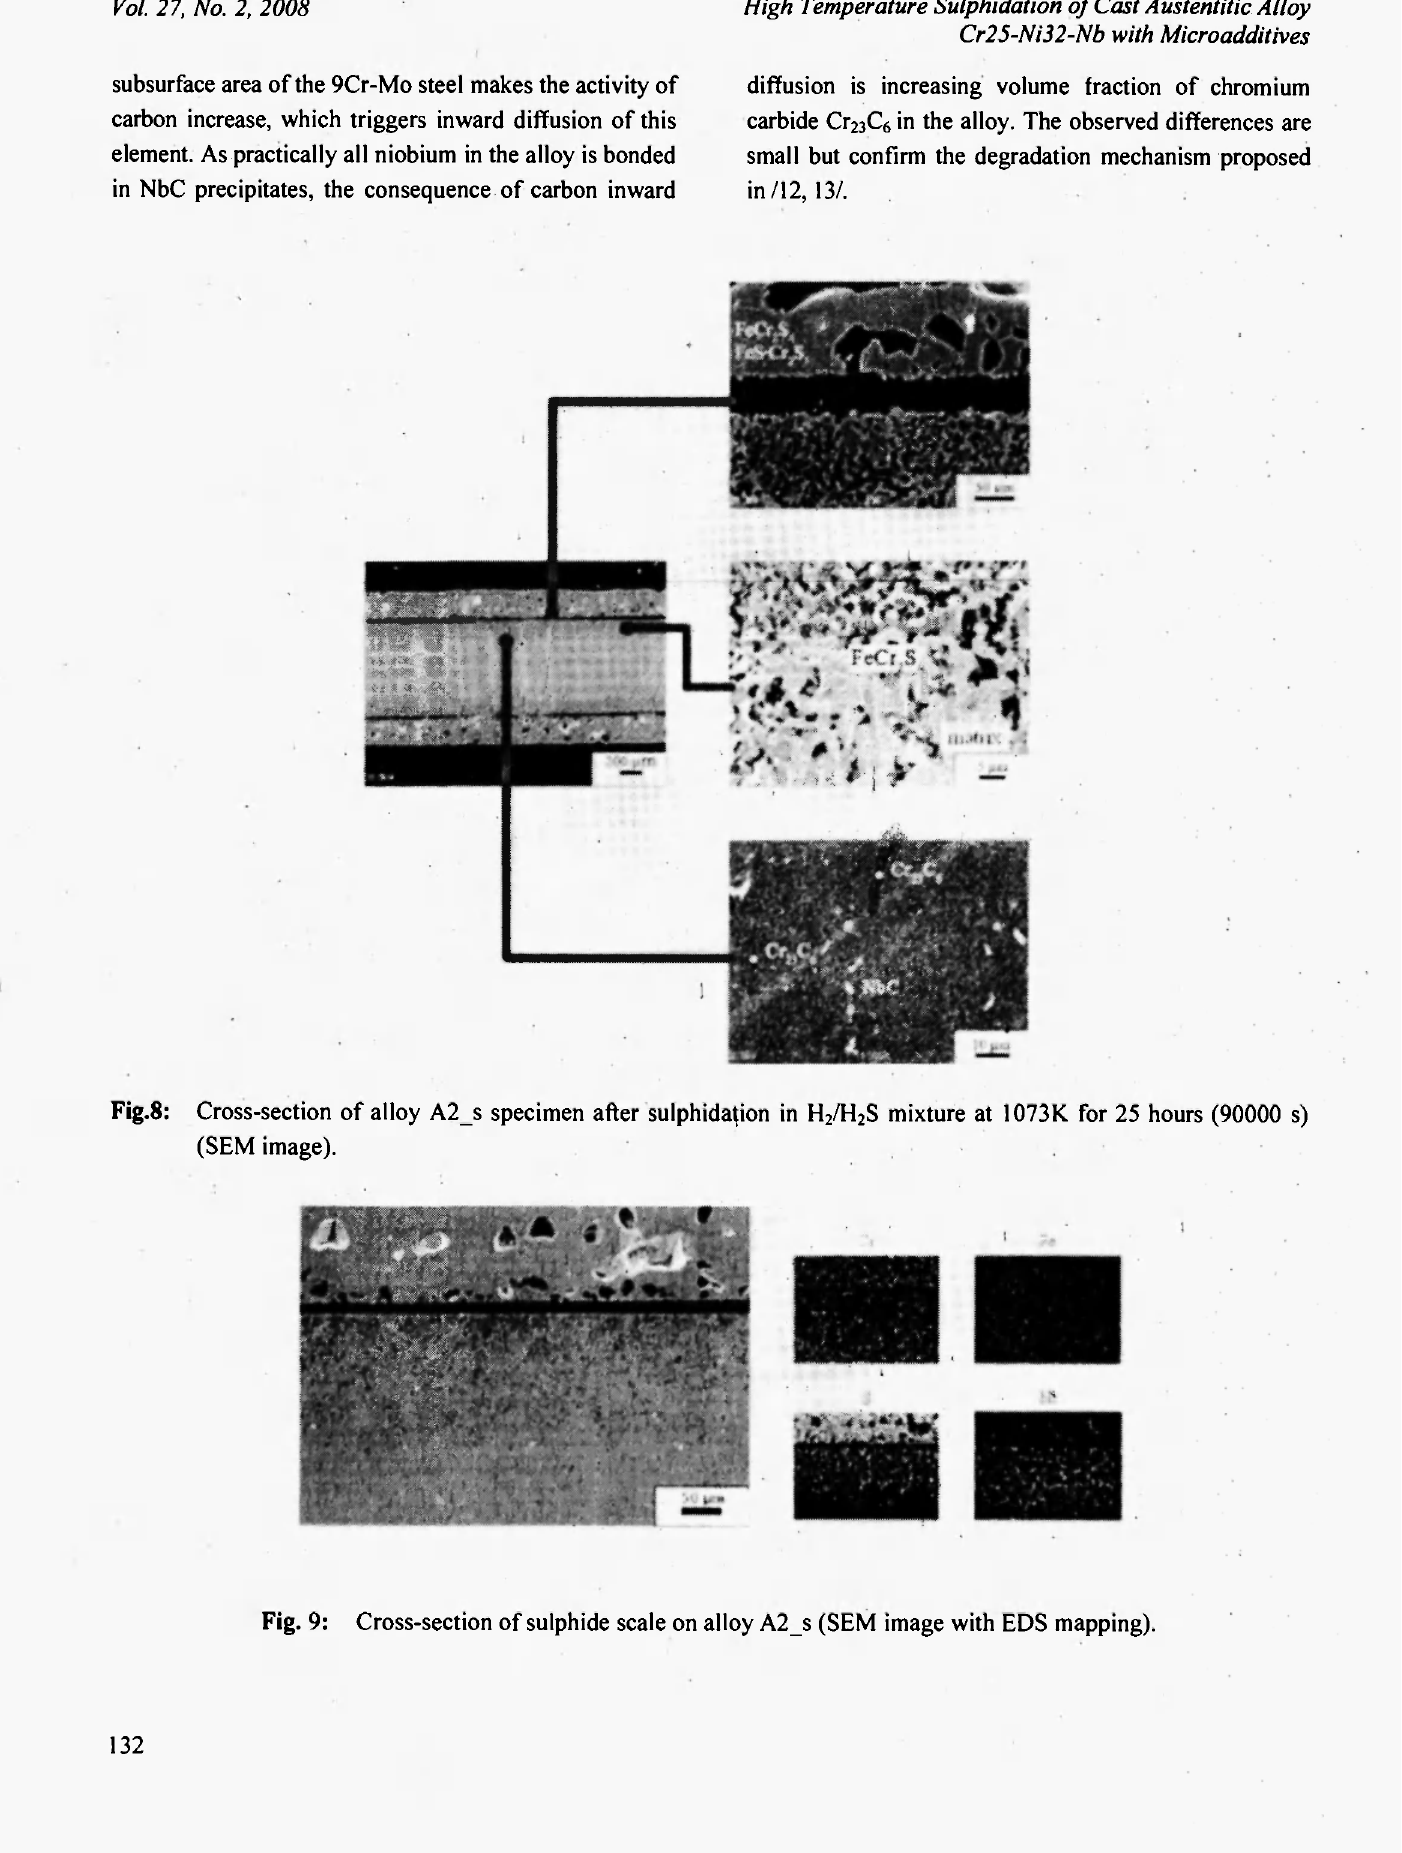
Fig.8: Cross-section of alloy A2_s specimen after sulphidation in H 2 /H 2 S mixture at 1073K. for 25 hours (90000 s) (SEM image).